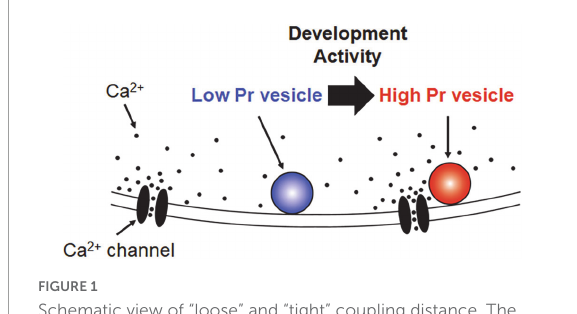
FIGURE1 Schematic view of “loose” and “tight” coupling distance. The distance from the voltage-gated calcium channels (VGCCs) (or VGCC clusters) is different between “tight” (red) and “loose” (blue) coupled vesicles. The release probability of “tight” coupled vesicles is high because they are located close to the Ca 2 + source, VGCCs, and hence exposed to a high concentration of Ca 2 + . On the other hand, the release probability of “loose” coupled vesicles is low because Ca 2 + is diluted and buffered before reaching its location. The coupling distance could change from “loose” to “tight” depending on the development and/or activity.